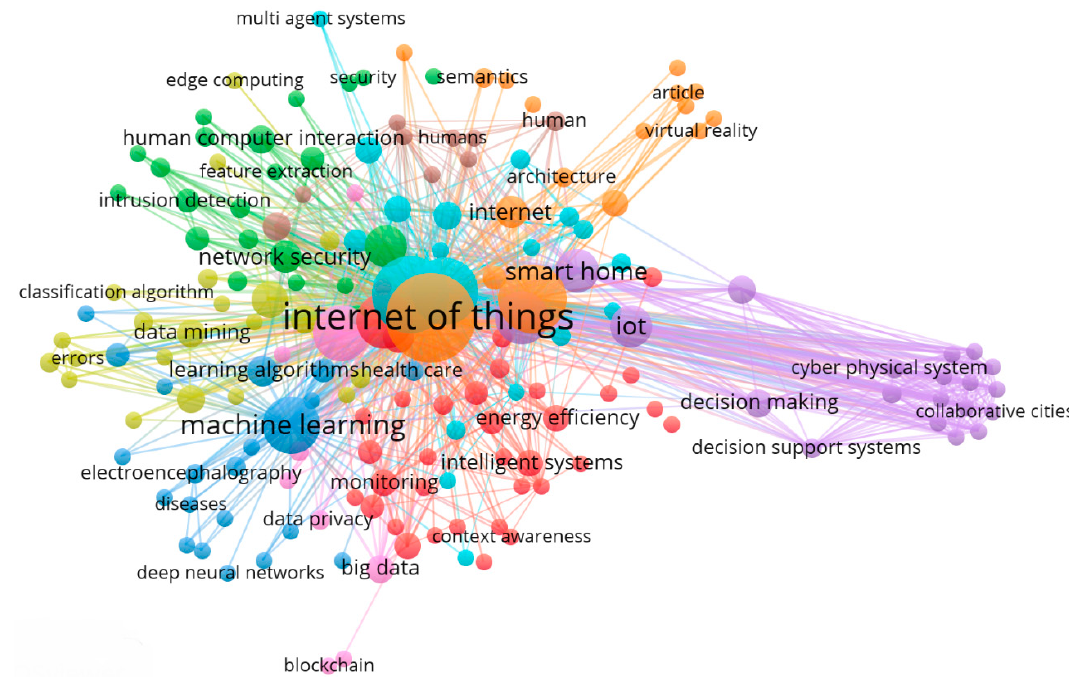
Figure 4. Co-occurrence analytical map of keywords created on the first bibliographic dataset. With the minimum number of co-occurrence of two, a total of 173 keywords out of the sample of 998 keywords are shown. Note: different colors show a different cluster of keywords.